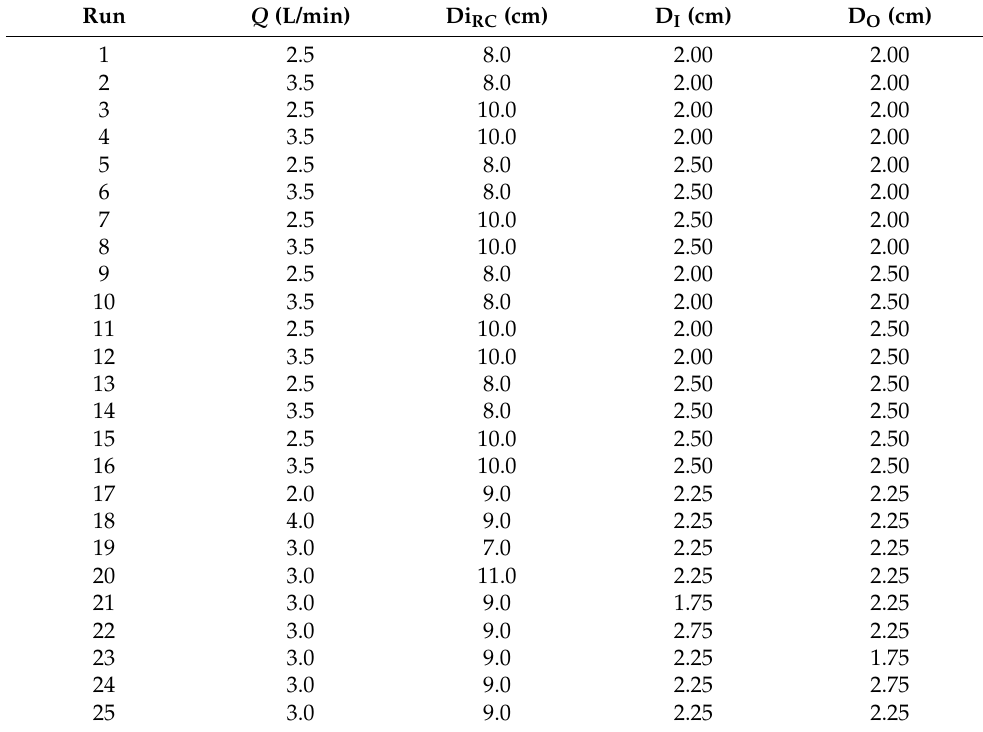
Table 5. Matrix of runs performed according to the upper inlet and outlet factorial design. Run Q (L/min) Di RC (cm)